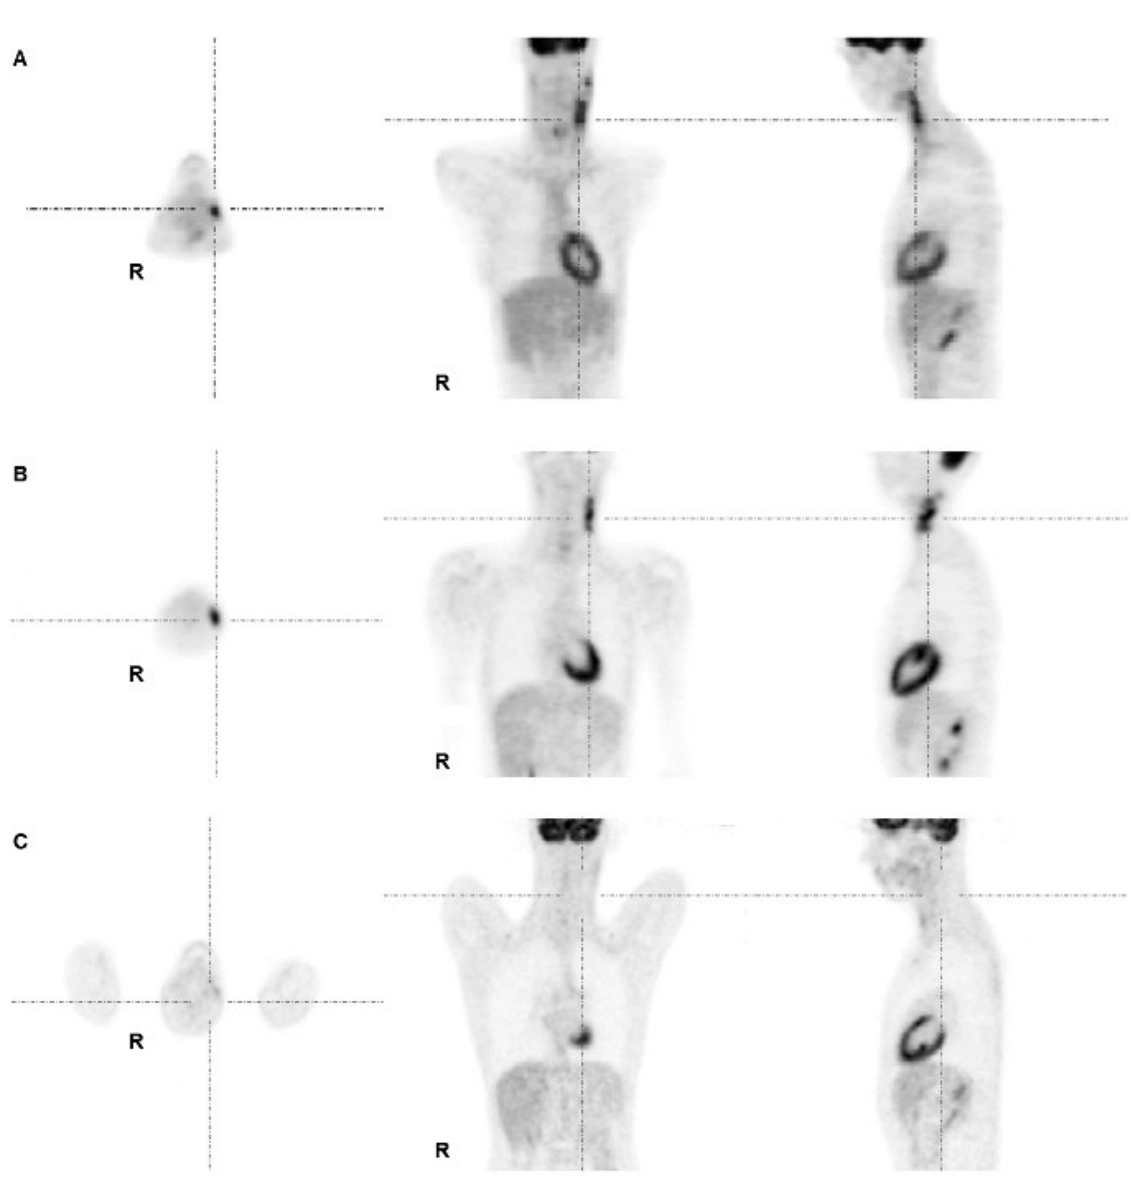
Figure 3. PET images of a 17-year-old male patient with lymphocyte rich HL stage I. ( A ) Lymphoma was initially localized in left cervical LN, and was treated according to